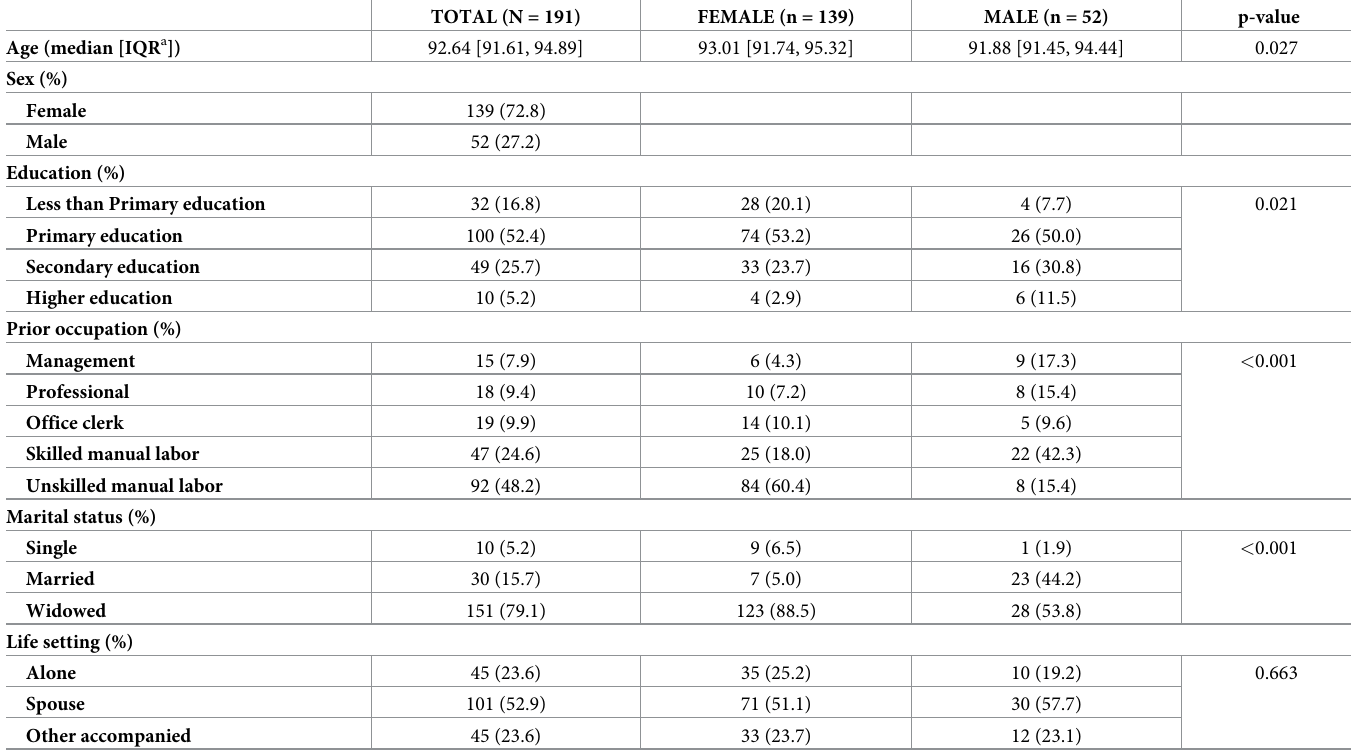
Table 1. Sociodemographic characteristics of the